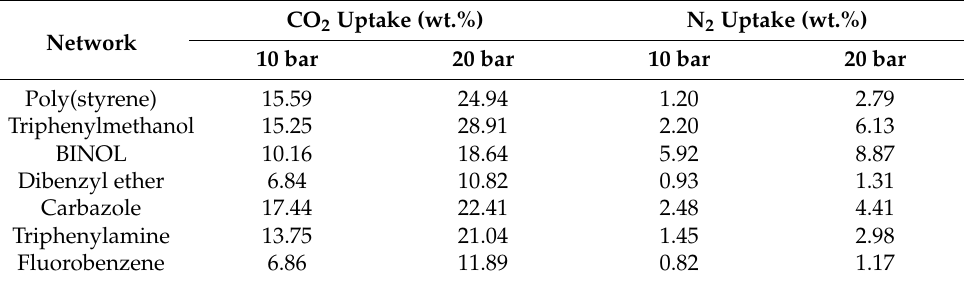
Table 2. Average CO 2 and N 2 uptake of HCP networks at 40 ◦ C.